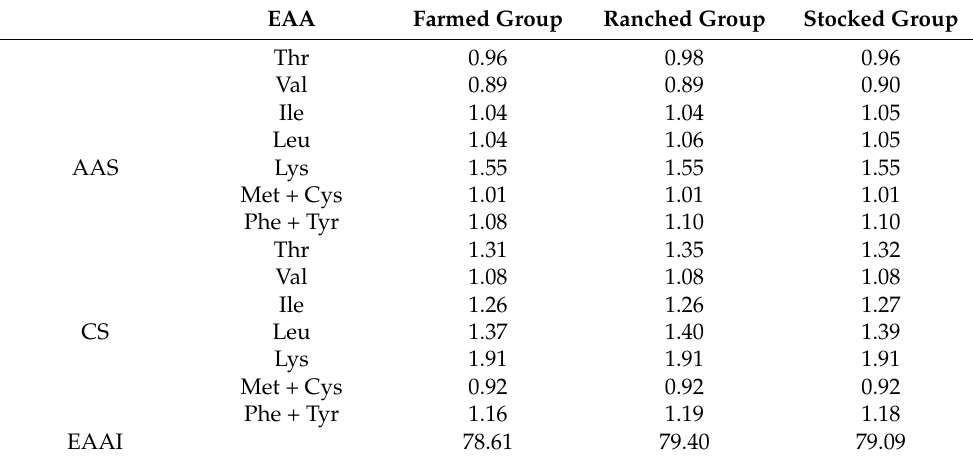
Table 4. Comparative analysis of AAS, CS and EAAI among three groups (g/100 g, dry